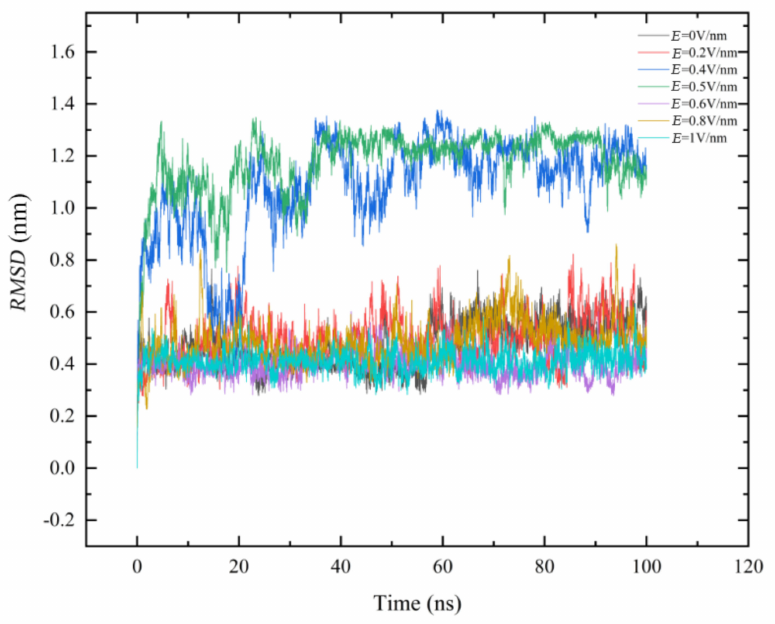
Figure 1. (Color online) Time evolution of backbone root mean square deviations ( RMSD ) as a function of time in 100 ns. Here, E = 0 V/nm (black line), E = 0.2 V/nm (red line), E = 0.4 V/nm (blue line), E = 0.5 V/nm (green line), E = 0.6 V/nm (purple line), E = 0.8 V/nm (yellow line), E = 1 V/nm (cyan